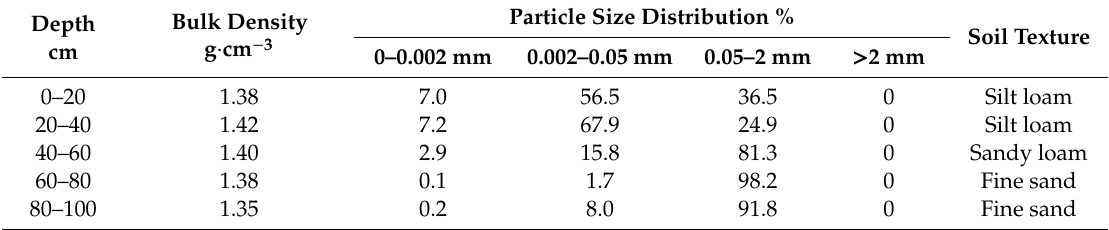
Table 1. Description of soils at the Xinjiang Agricultural University’s Linguo Experimental Station in Hongqipo, Wensu County, Aksu Prefecture, China.